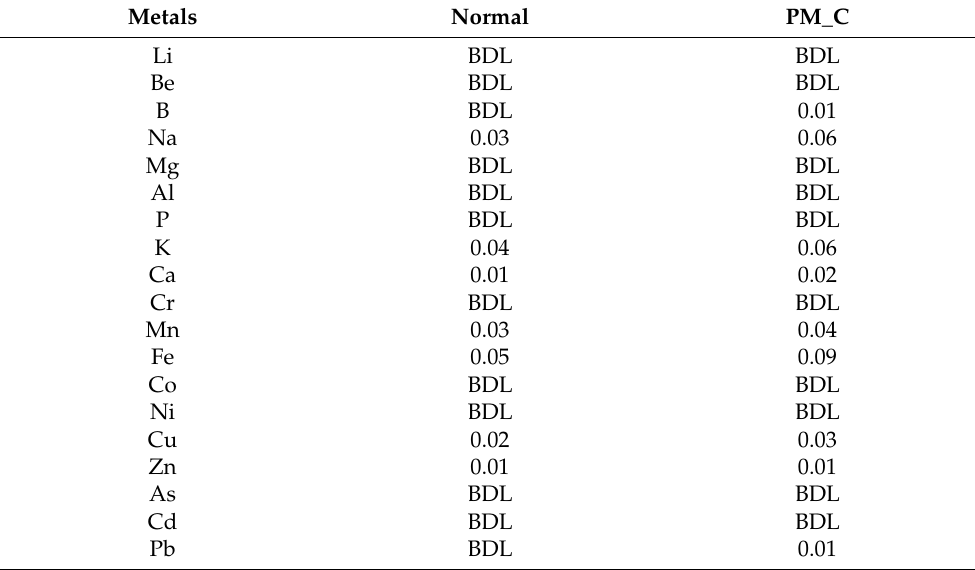
Table 2. ICPMS data showing metal deposition in mitochondria (values in PPM) (BDL: below detection limit) ( n = 3 per